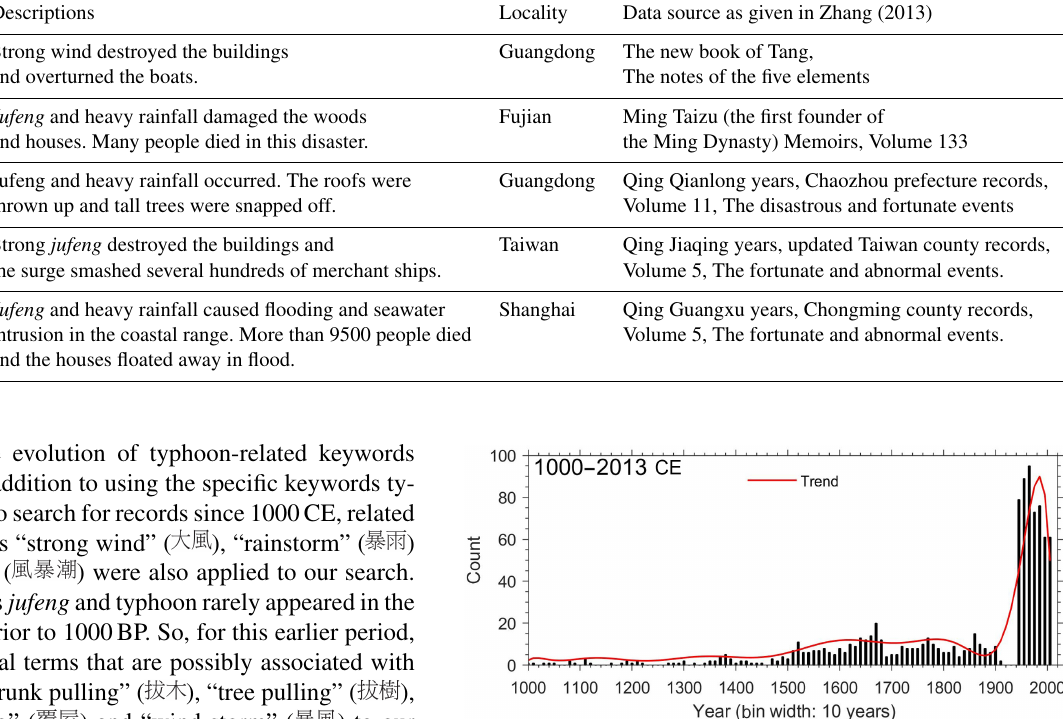
Table 1. Illustrative quotations from selected historical sources in China.